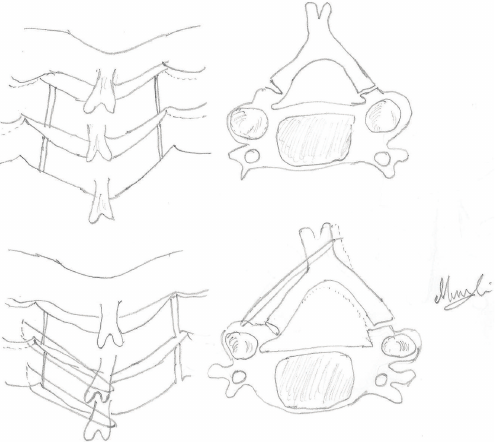
Figure 1: (a) The laminae which are bilateral troughs (complete on one side and incomplete on the other) made at the junction of laminae and lateral masses. (b) Greensticking on the incomplete trough side so that spinal canal is now expanded. Figures redrawn from Steinmetz and Resnick [6].